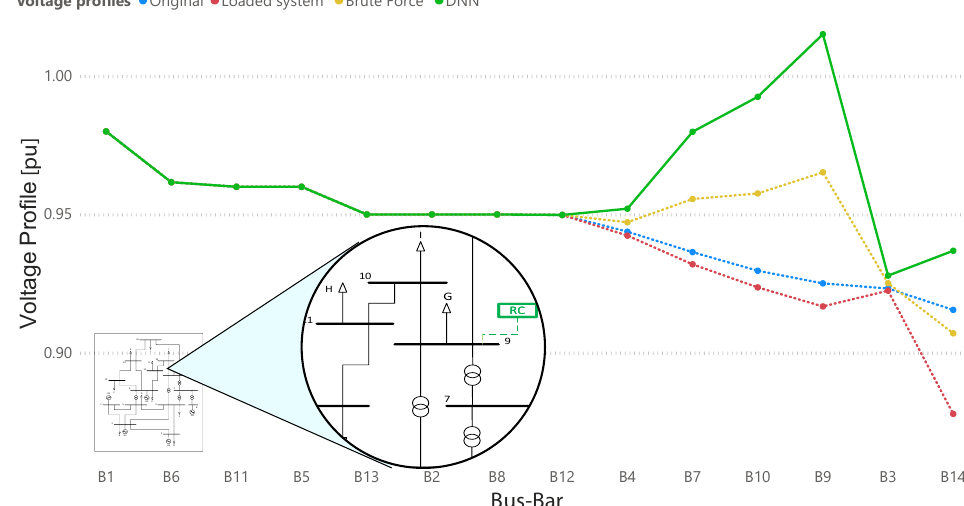
Figure 6. Voltage profiles for 14 bus-bar system: original system, loaded system, BFA and DNN compensation—where DNN results are better than